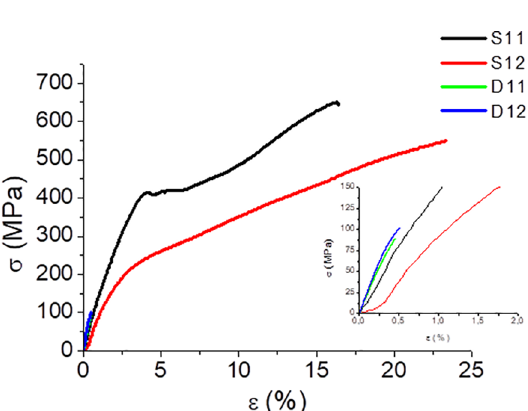
Figure 8. Partial diluted zones (a) D11 (b) D12.